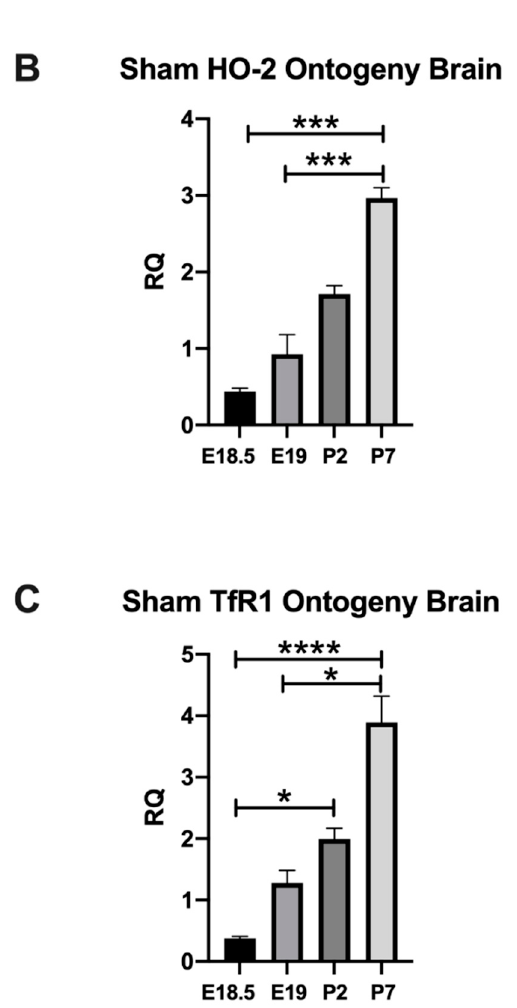
Figure 2. Ontogeny of HO-1, HO-2, and TfR1 in Sham Brains. Normal developmental regulation of HO-1 (( A ) n = 3, 5, 10, 7, P2 vs. E18.5, * p = 0.0394), HO-2 (( B ), n = 6, 8, 7, 7, P7 vs. E18.5, *** p = 0.0006, P7 vs. E19, *** p = 0.0009), and TfR1 (( C ), n = 7, 8, 6, 7, P2 vs. E18.5, * p = 0.0169, P7 vs. E18.5, **** p < 0.0001, P7 vs. E19, * p = 0.0275) is displayed at E18.5, E19, P2, and P7 respective postnatal ages. p significant when <0.05, Kruskal–Wallis test, mean ± SEM.